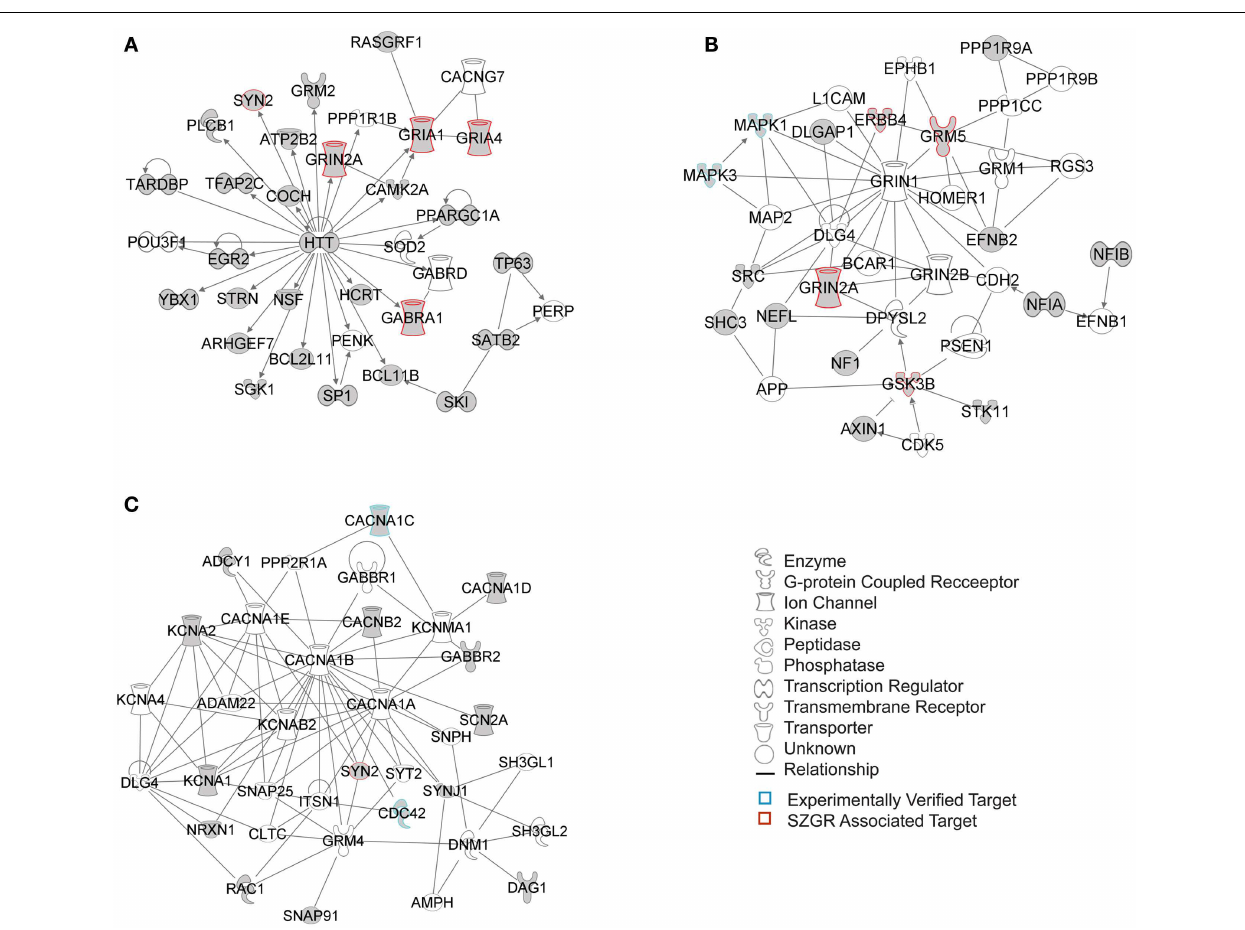
White molecules are those not included in the uploaded dataset but added by IPA. Gray molecules indicate those that were included in the uploaded dataset. Relationships depicted by lines with arrows represent “act on,” while lines without arrows represent binding. See figure keys for identification of the types of molecules included. Blue outlines depict experimentally validated targets and those in red indicate SZGR associated